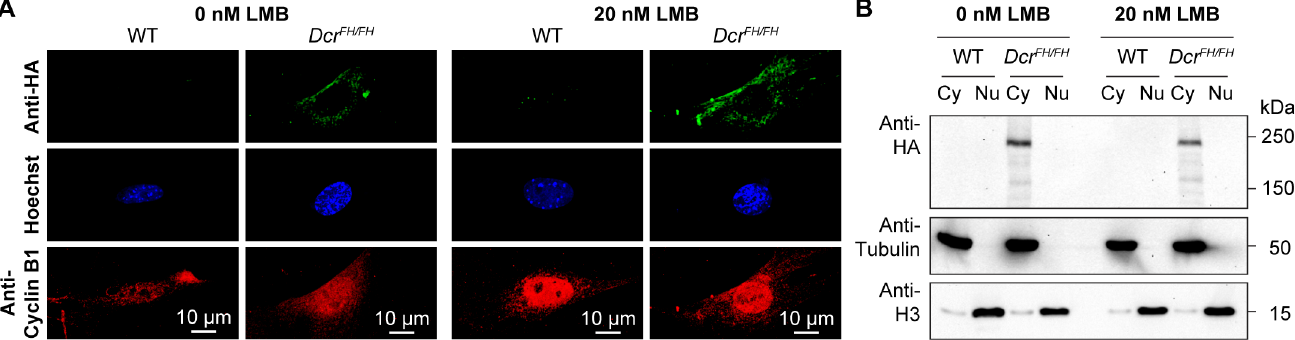
Fig 2. Dicer is not a nucleocytoplasmic shuttling protein. (A) Confocal micrographs showing immunofluorescence anti-HA staining of wild type and Dcr FH/FH PMEFs without and with LMB-induced inhibition of nuclear export. Cells were treated with 20 nM LMB or solvent for 6 h. Cyclin B1 served as a positive control for the LMB treatment. Nuclei are stained with Hoechst. Scale bars represent 10 μ m. (B) Western blot analysis after LMB treatment and subcellular fractionation. Anti-HA antibody was used on cytoplasmic (Cy) and nuclear (Nu) extracts, where tubulin served as a cytoplasmic marker and histone H3 as a nuclear